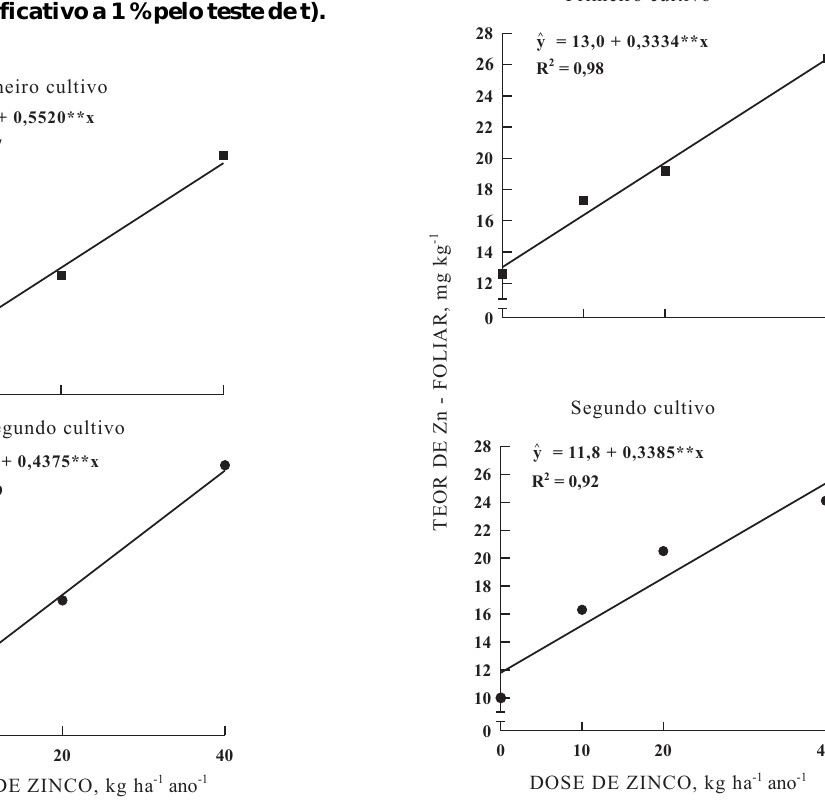
Figura 3. Teor de Zn no solo extraído por DTPA em função de doses de zinco, via solo, em dois cultivos. (**significativo a 1 % pelo teste de t).